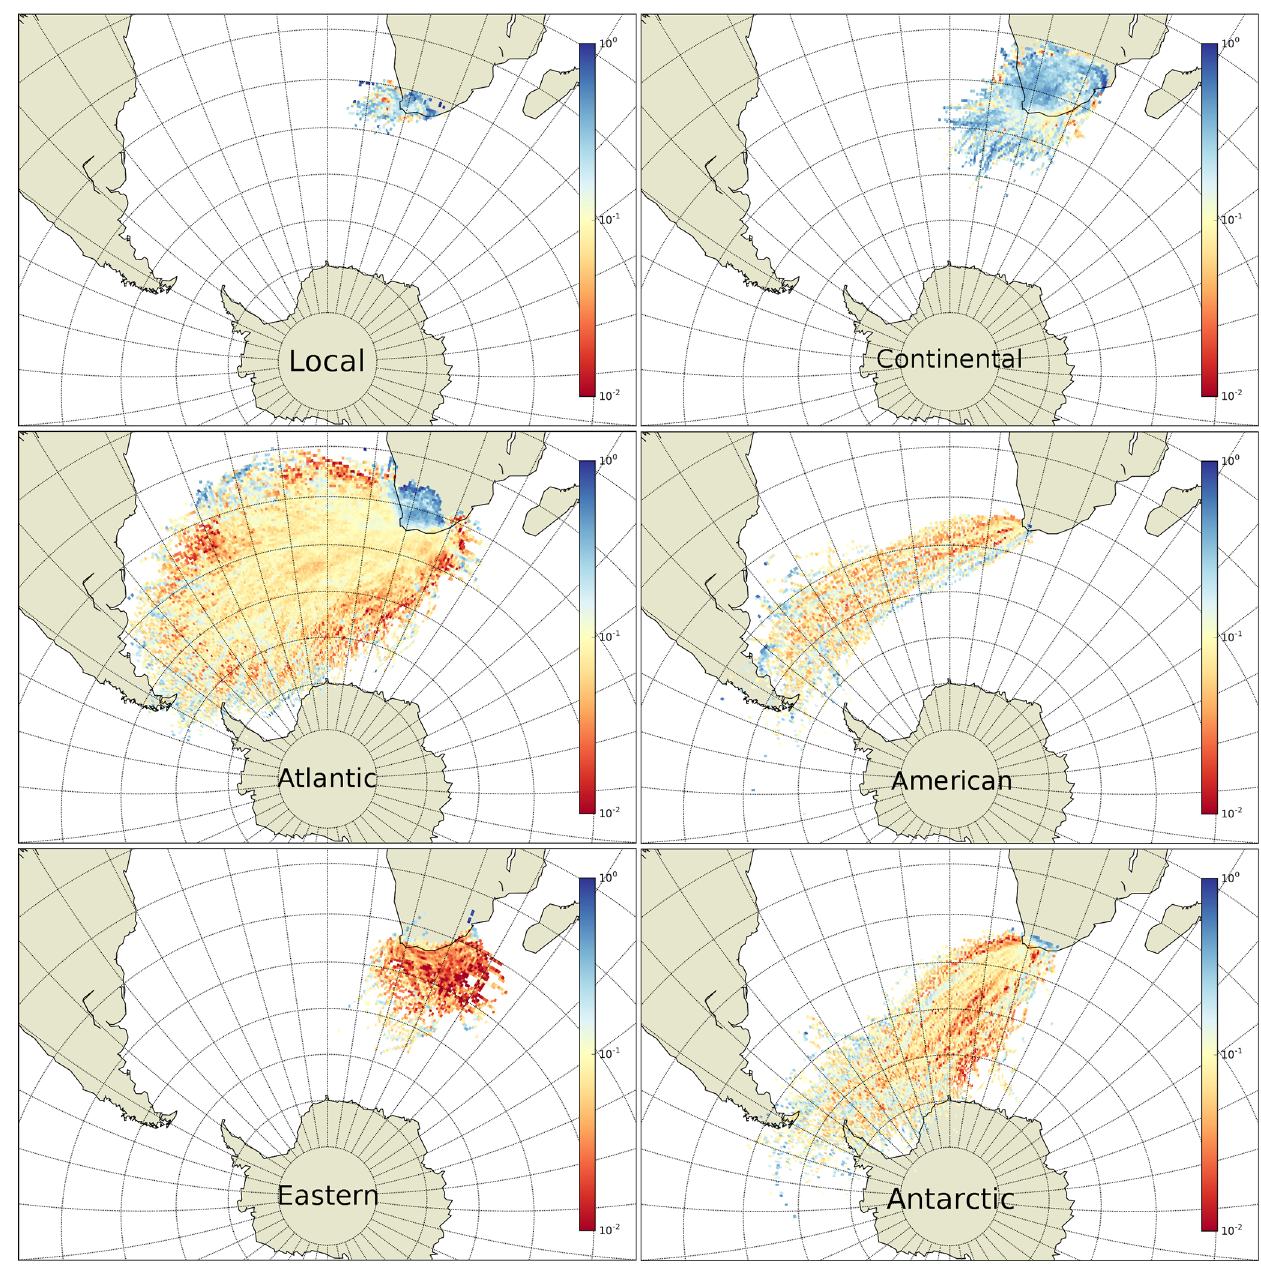
Figure 7. The 10th percentile lowest Hg concentrations for six source regions. Blue colours indicate sink regions, red colour absence of sinks. Low values are almost exclusively linked to Continental and Local air